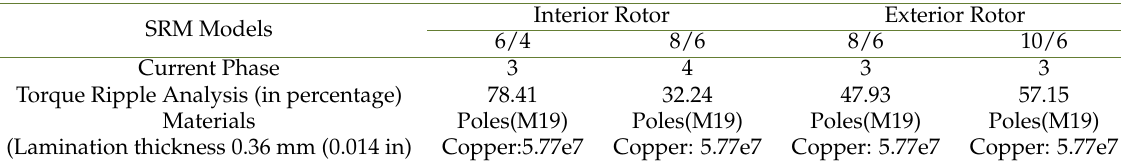
Table 3. Interior and Exterior rotor torque ripple